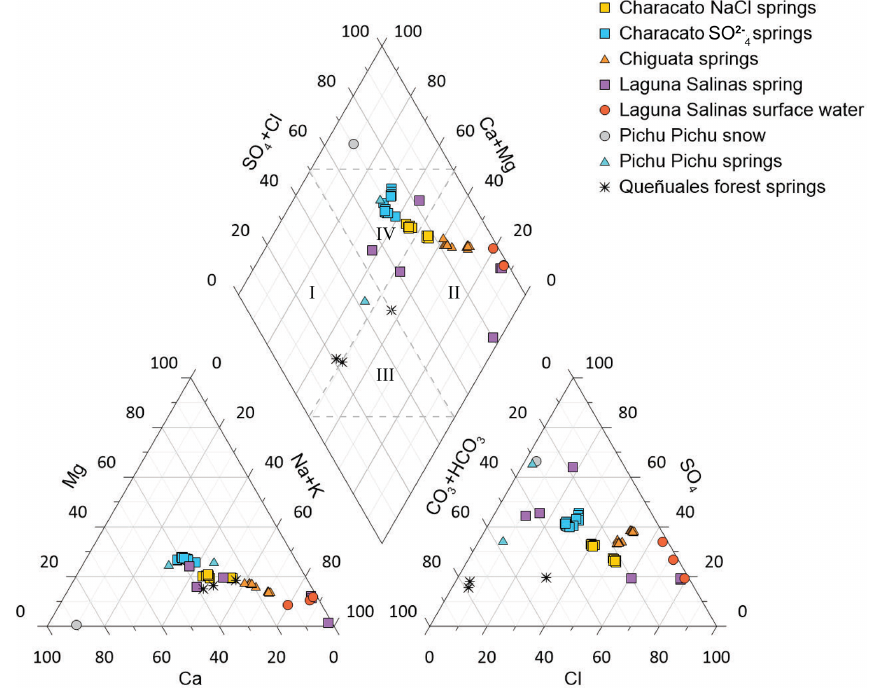
Figure 5. Piper diagram of all groundwater samples, Lagunas Salinas surface water, and snow sample in this study. Quadrant I represents calcium-bicarbonate waters, quadrant II represents sodium chloride waters, quadrant III represents sodium bicarbonate waters, and quadrant IV represents calcium sulfate